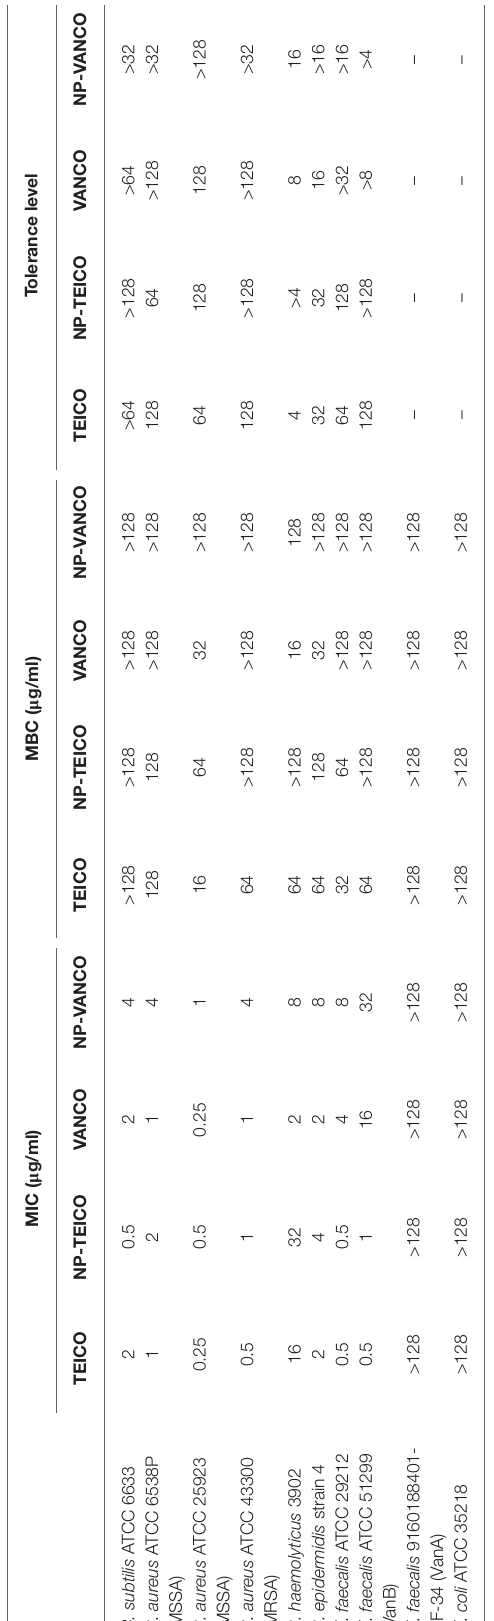
( Supplementary Figure S4 ) confirmed the bactericidal effect of nanoconjugated antibiotics on S. aureus and B. subtilis . In this assay, viable cells are stained green by the Syto9 fluorescence dye, whereas nonviable cells are stained red by propidium iodide fluorescence dye (Arakha et al., 2015). Untreated cells of both S. aureus ATCC 25923 and B. subtilis ATCC 6633 ( Supplementary Figures S4A,B ) were stained green by Syto9 dye, indicating the presence of 85% viable cells for B. subtilis and 98% for S. aureus . Instead, cells turned red after exposure to ( Supplementary Figures S4G–J ), thus confirming the bactericidal effect of GPAs in both forms. Interestingly, when NP-TEICO or NP-VANCO was present, bacteria tended to aggregate on them ( Supplementary Figures S4E,F,I,J ), further favouring the clearance of bacterial